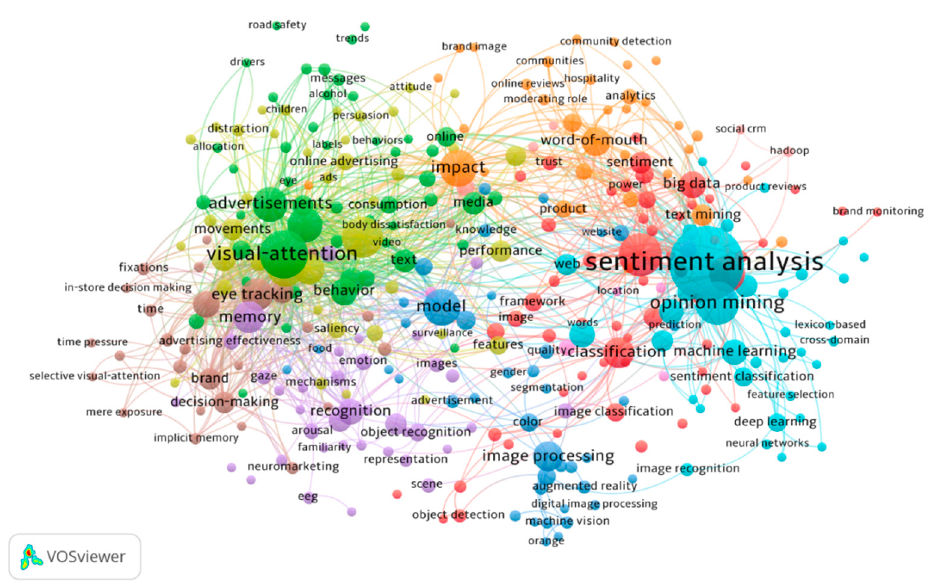
Figure 8. Co-Occurrence analysis. The relatedness of items is determined based on the number of documents in which they occur together (all keywords). Minimum number of occurrences of a keyword was 3. Of the 3094 keywords, 332 met the threshold.